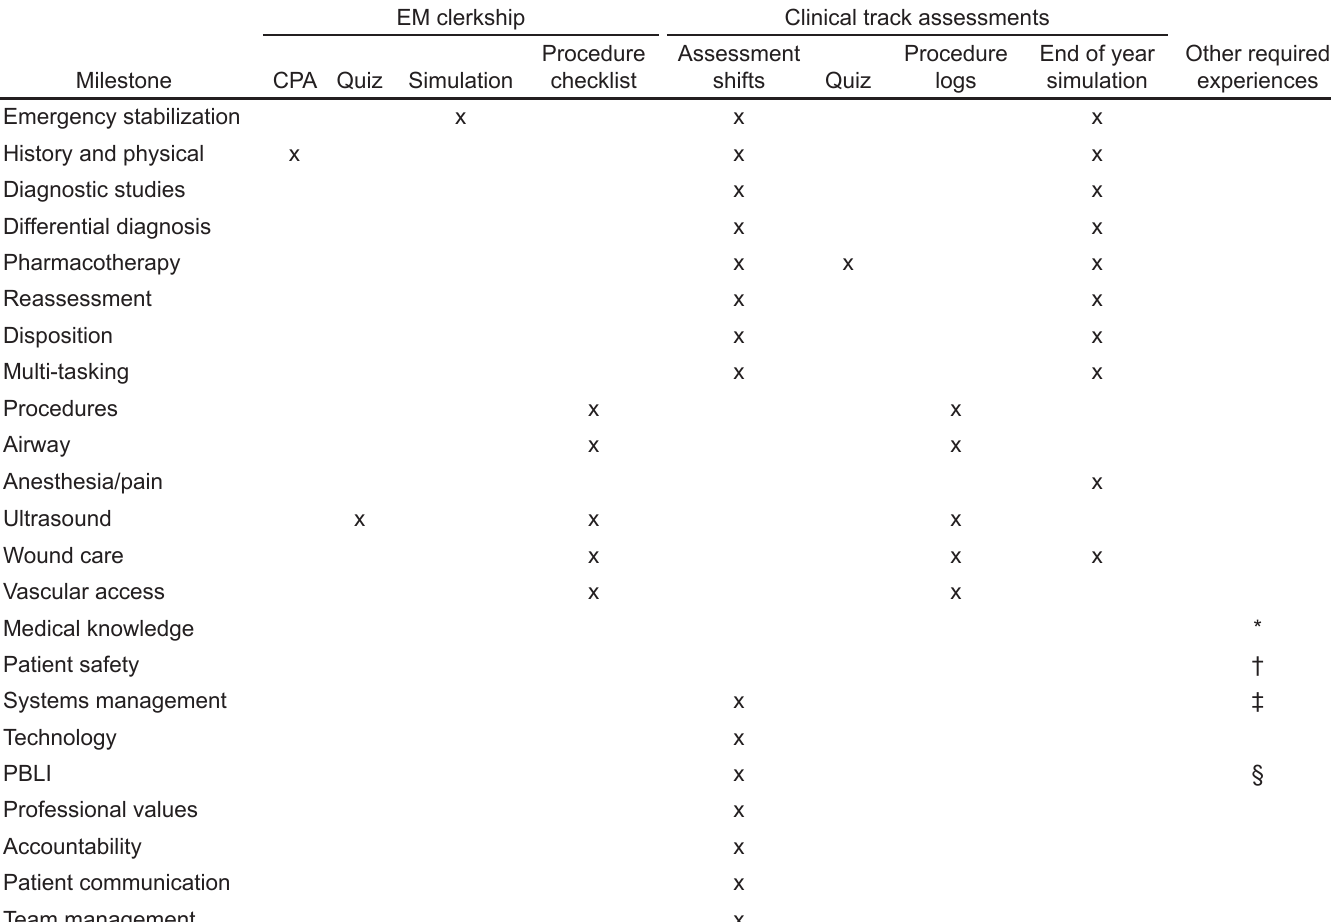
Table 1. Methods of assessment in a milestone-based Clinical Track in Emergency Medicine, as part of a fourth-year medical school